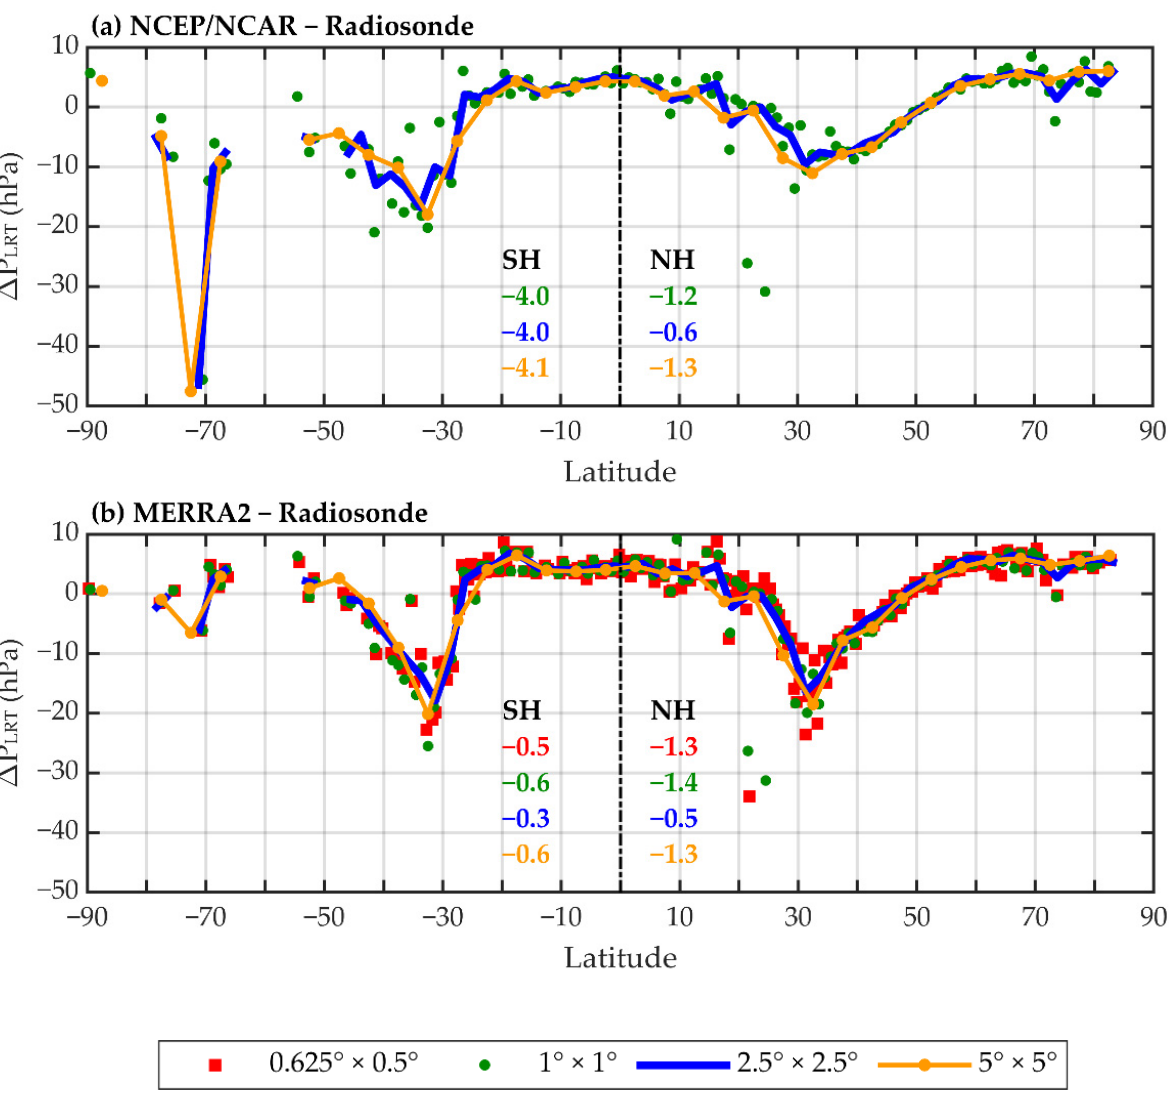
Figure 5. ( a ) The zonal mean P LRT difference ( Δ P LRT , in hPa) over 1980–2017 between NCEP/NCAR and radiosonde data at different horizontal resolutions. The text indicates the hemispheric mean, which is calculated as the cosine-weighted latitudinal average of monthly 10 ◦ -zonal mean differences. ( b ) The same as ( a ), but for the P LRT difference between MERRA-2 and radiosonde data.